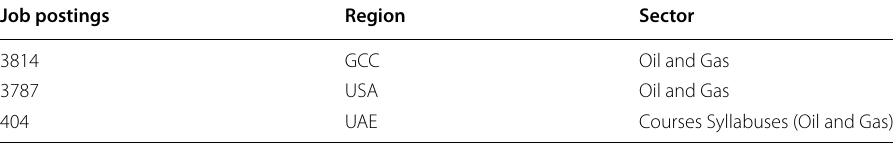
Table 1 Number of job postings and course syllabuses collected in each of the mentioned regions Job